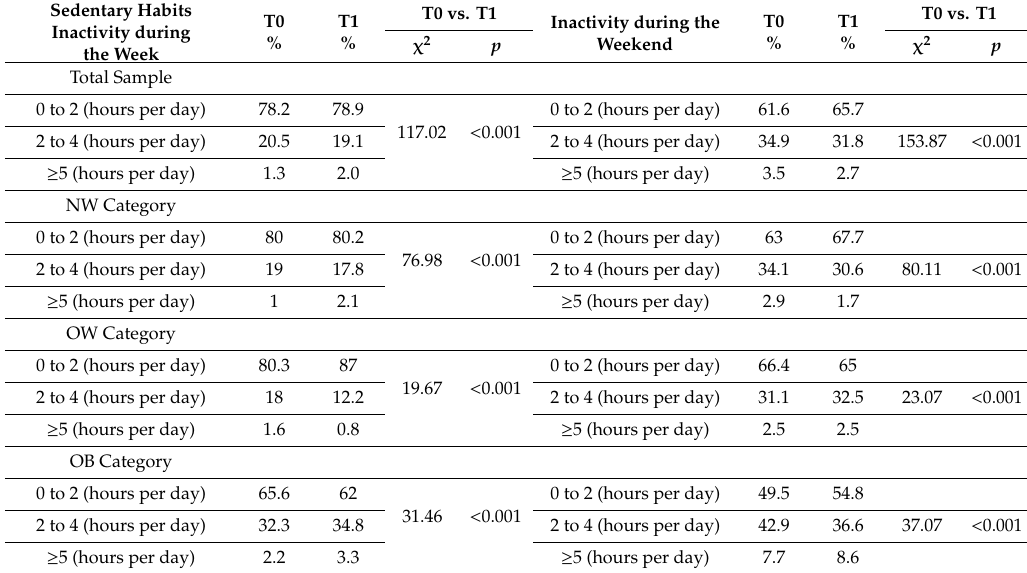
Table 3. Chi-square to analyze di ff erence in the sedentary behavior between T0 and T1 in Total Sample a separately for BMI